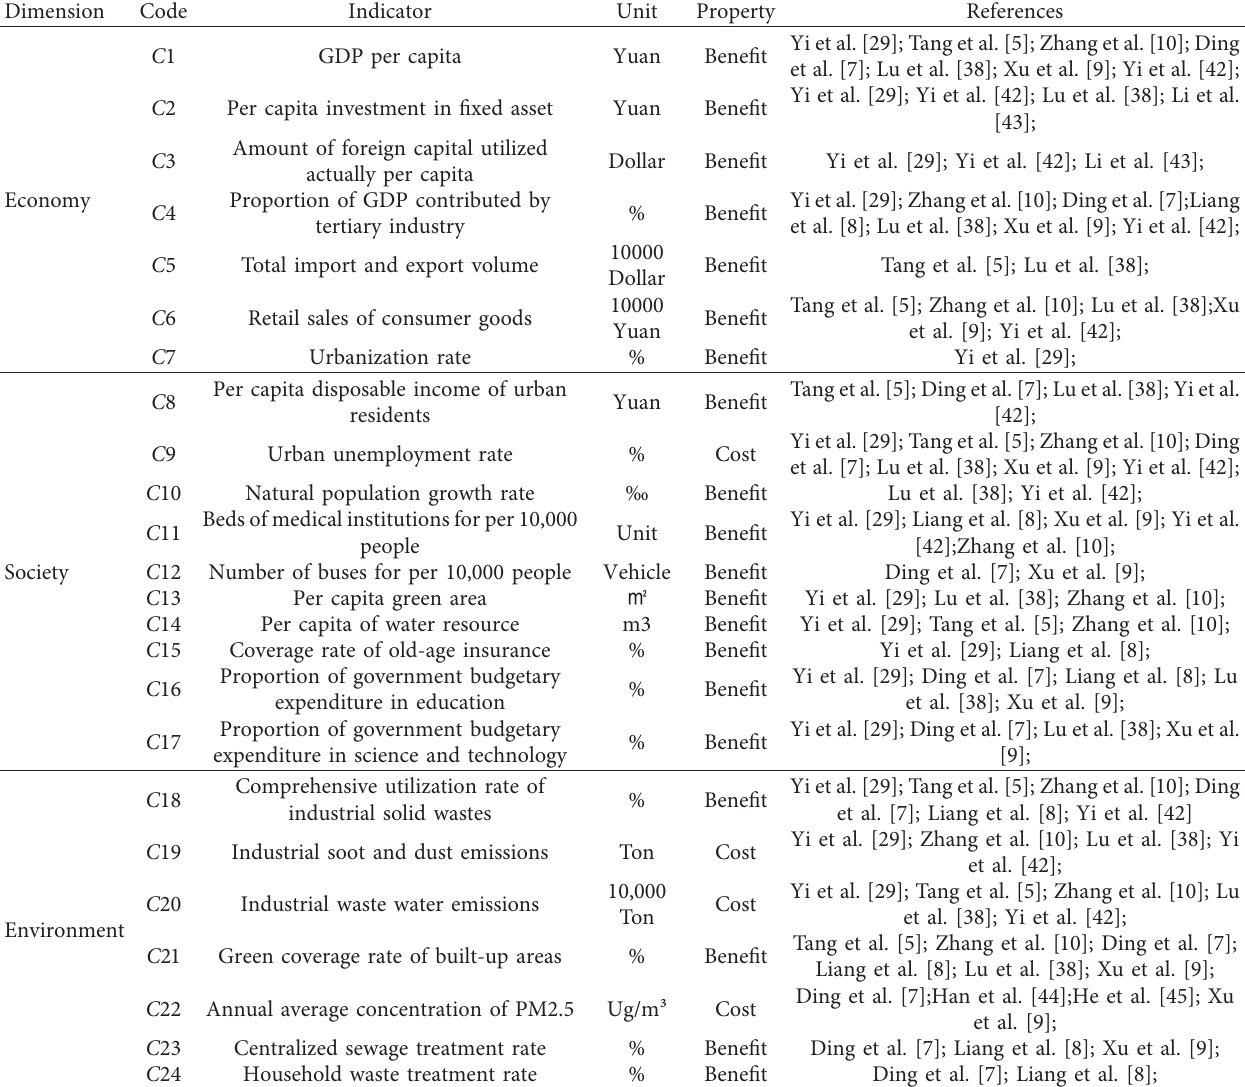
Table 1: Urban sustainability evaluation indicator